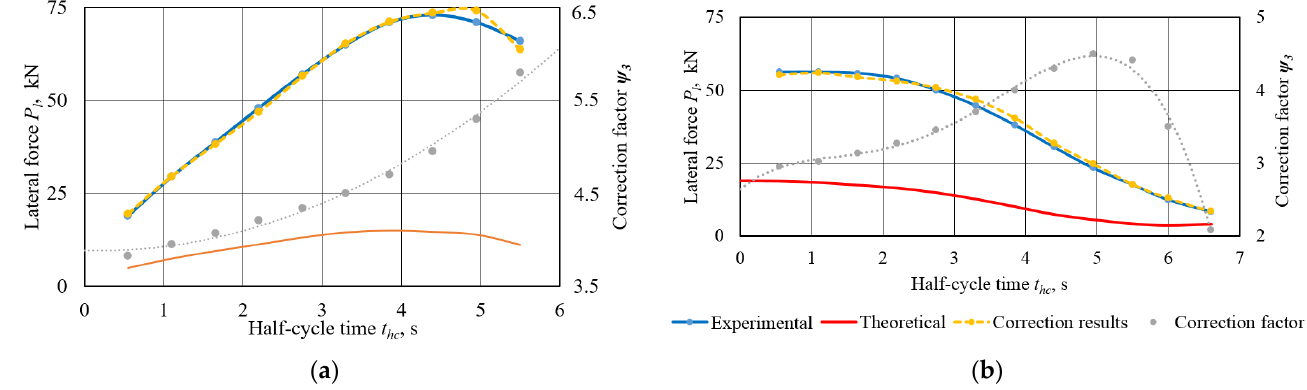
Figure 12. Change of lateral force on the operating equipment of the universal earthmoving machinery during the half-cycle: ( a ) without the intermediate frame rotation; ( b ) with the intermediate frame rotation (C = 15, B = 4.5 m, V ls = 0.7 m/s, V c = 6 m/s, V s = 104 m/h).